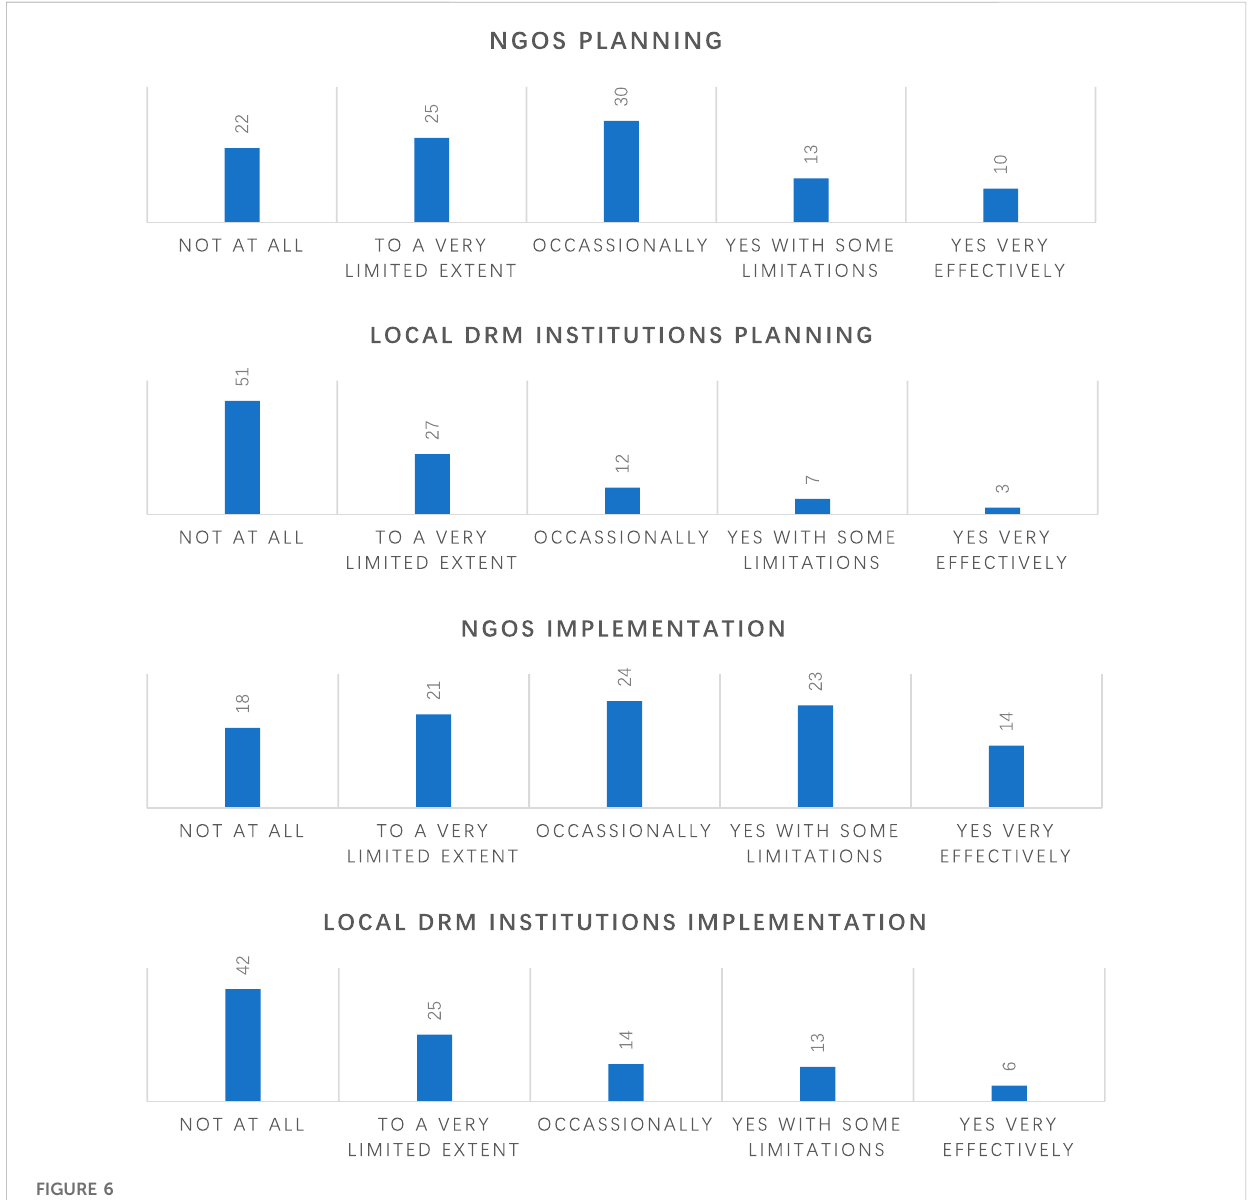
FIGURE 6 Level of local community involvement in planning (preparing policies, plans, and actions to mitigate risks) and implementation (implementing measures to reduce risks) by NGOs and Local DRM